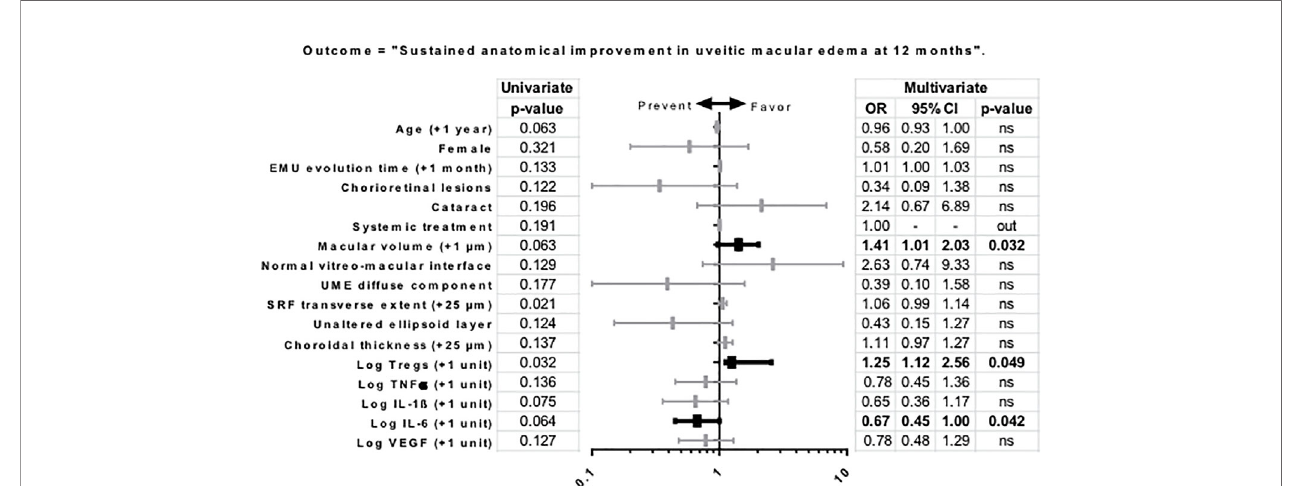
FIGURE 2 | Uni and multivariate regression model of variables as predictors of anatomic outcome in uveitic macular edema. Outcome: “ sustained anatomical improvement ” , de fi ned as per decrease ≥ 20% or reaches <300 µm in central subfoveal thickness at 6 months and maintained through month 12. All covariates (P < 0.20) included in the multivariable model are shown. Quantitative variables were transformed to log scale. Statistically signi fi cant associations (P-value < 0.05) are noted in bold. Hosmer-Lemeshow goodness-of- fi t test, P = 0.13. Abbreviations: CI, con fi dence interval; OR, odds ratio; UME, uveitic macular edema; SRF, subretinal fl uid; TNF, tumor necrosis factor; IL, interleukin; VEGF, vascular endothelial growth factor; Tregs, regulatory T